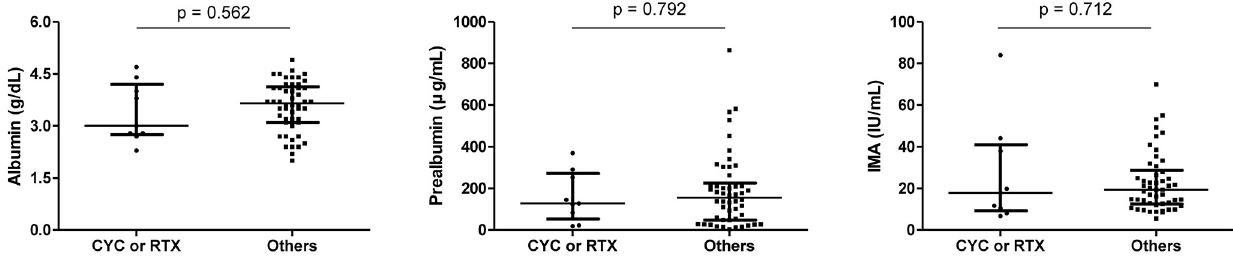
Fig 4. Comparison of baseline albumin, prealbumin, and ischemia-modified albumin levels according to treatment. Albumin, prealbumin, and ischemia-modified albumin levels were not significantly different in patients with concurrent treatment with cyclophosphamide or rituximab and in those without. The error bars present median and interquartile range. CYC: cyclophosphamide; RTX: rituximab; IMA: ischemia-modified albumin.